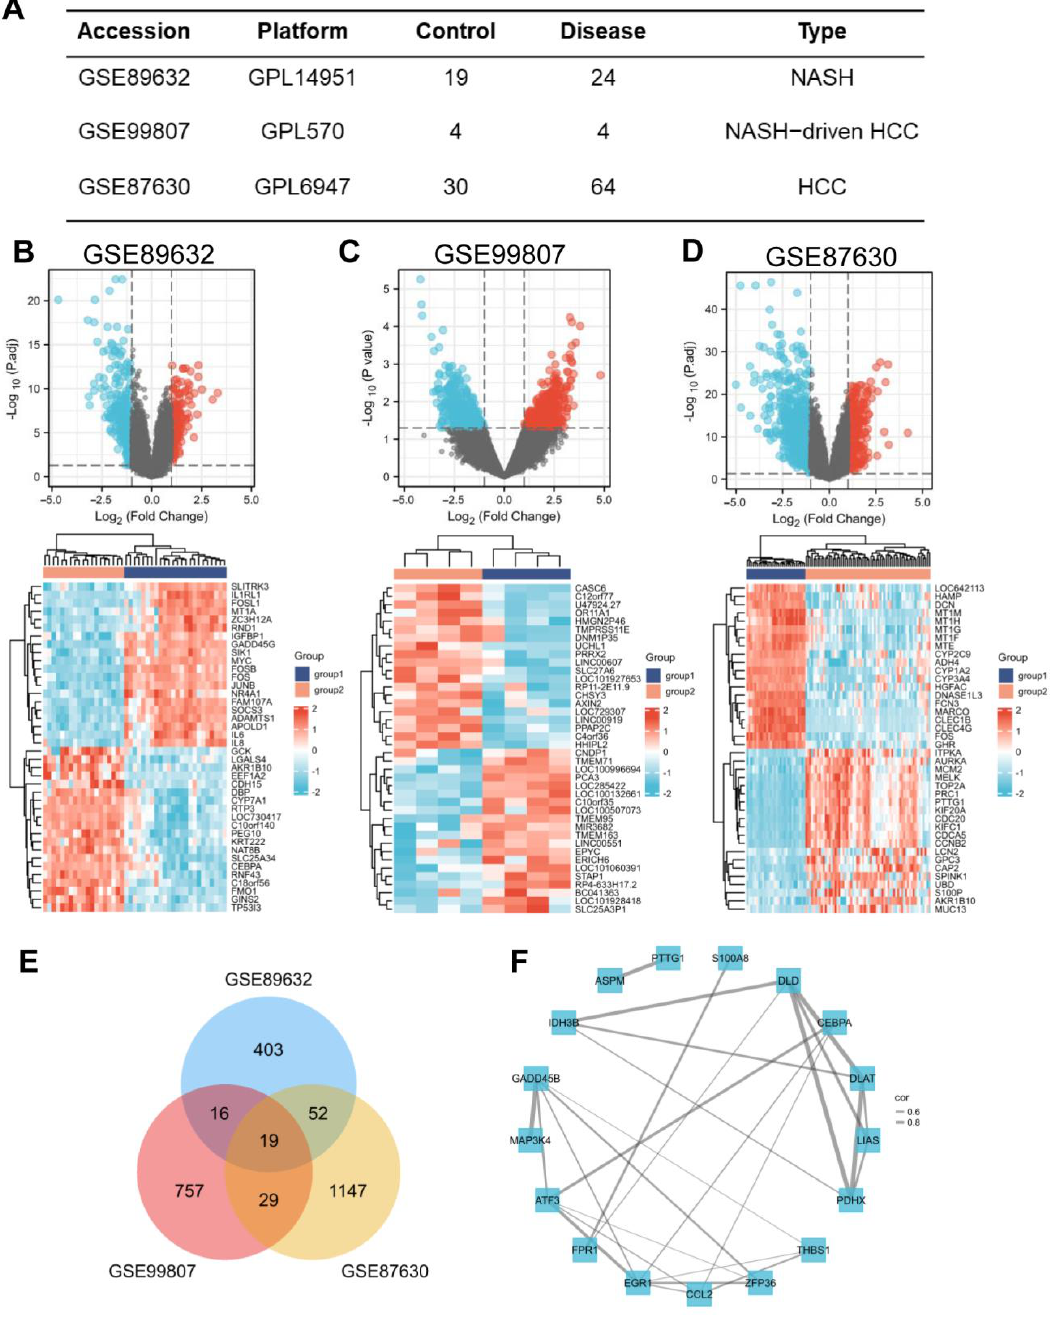
Figure 1. Screening of the common DEGs in NASH and HCC. ( A ) Description of datasets used to screen DEGs. ( B − D ) The volcano plots (|log2(FC)| > 1, adj. p < 0.05) and heatmap plots (top 20) of DEGs in GSE89632, GSE99807, and GSE87630. ( E ) Overlap of DEGs from 3 datasets found 19 valuable genes. ( F ) Protein–protein interaction network of 19 DEGs among NASH and HCC. The width of the edge represents the correlation.